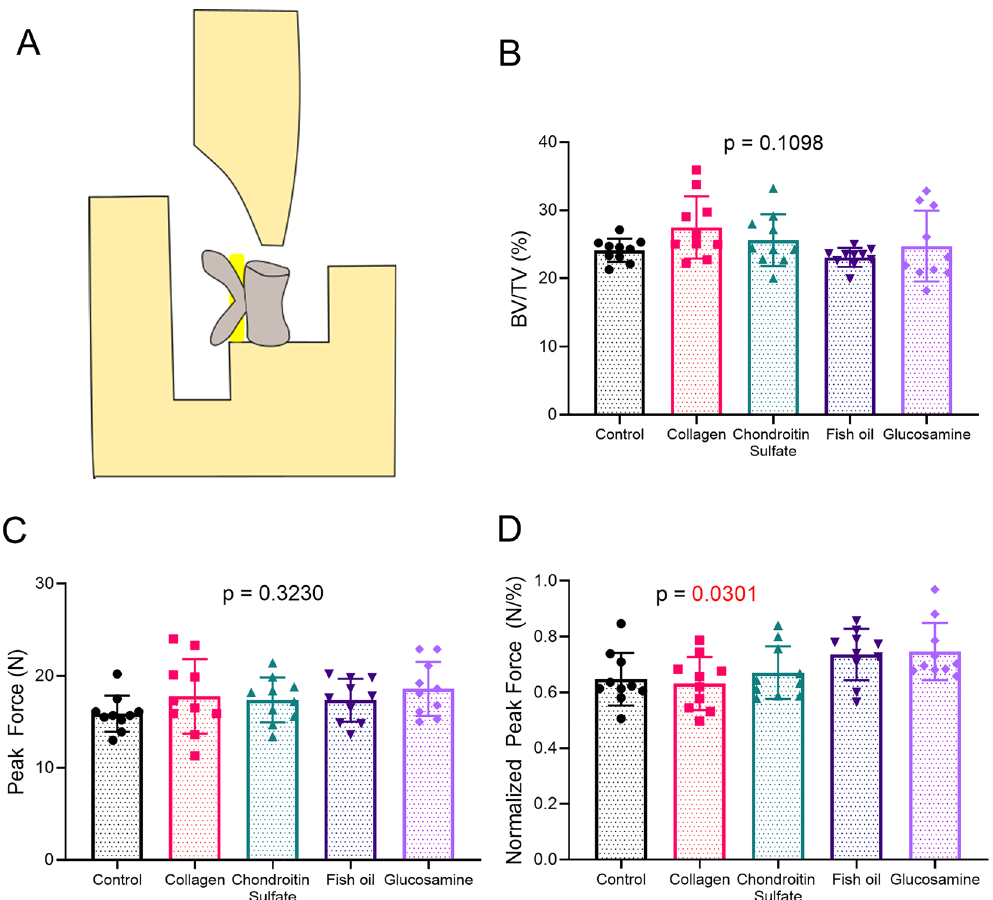
Figure 3. Compression testing of vertebrae. Schematic of compression fixtures with vertebrae ( A ), bone volume fraction of vertebral trabecular bone ( B ), peak force during compression ( C ), and peak force normalized to the bone volume fraction of vertebral trabecular bone ( D ). Overall ordinary one way ANOVA or Kruskal Wallis p values are given above graphs.